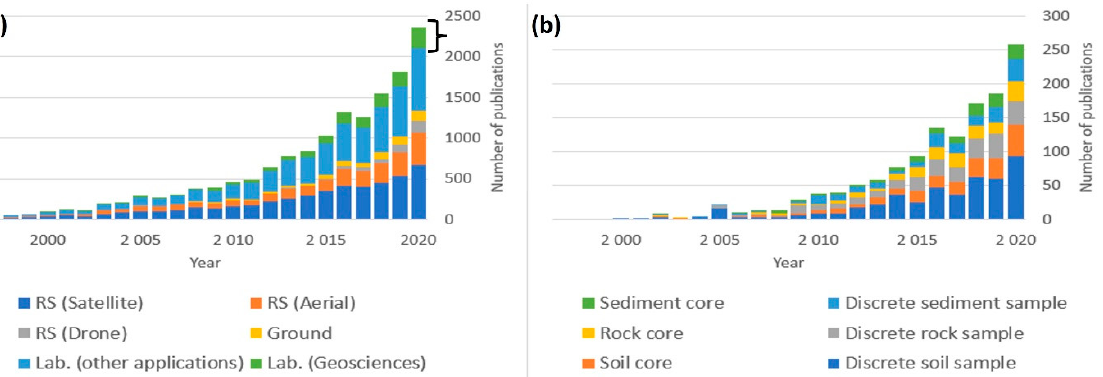
Figure 3. Peer-reviewed publications for ( a ) HSI in several conditions (RS: Remote Sensing,